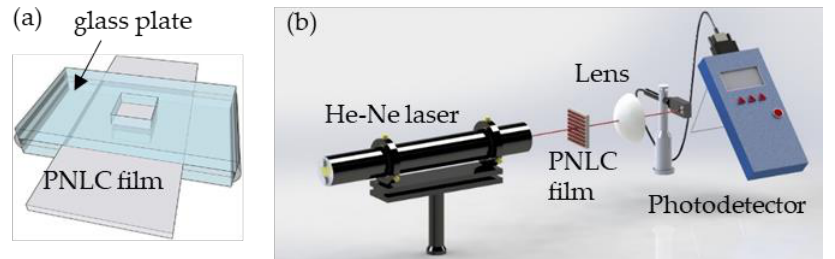
Figure 2. ( a ) PDLC film framed by glass plate with a square hole with a side length of 1.0 cm; ( b ) measurement of transmittances of patterned and planar PDLC films that are exposed to organic